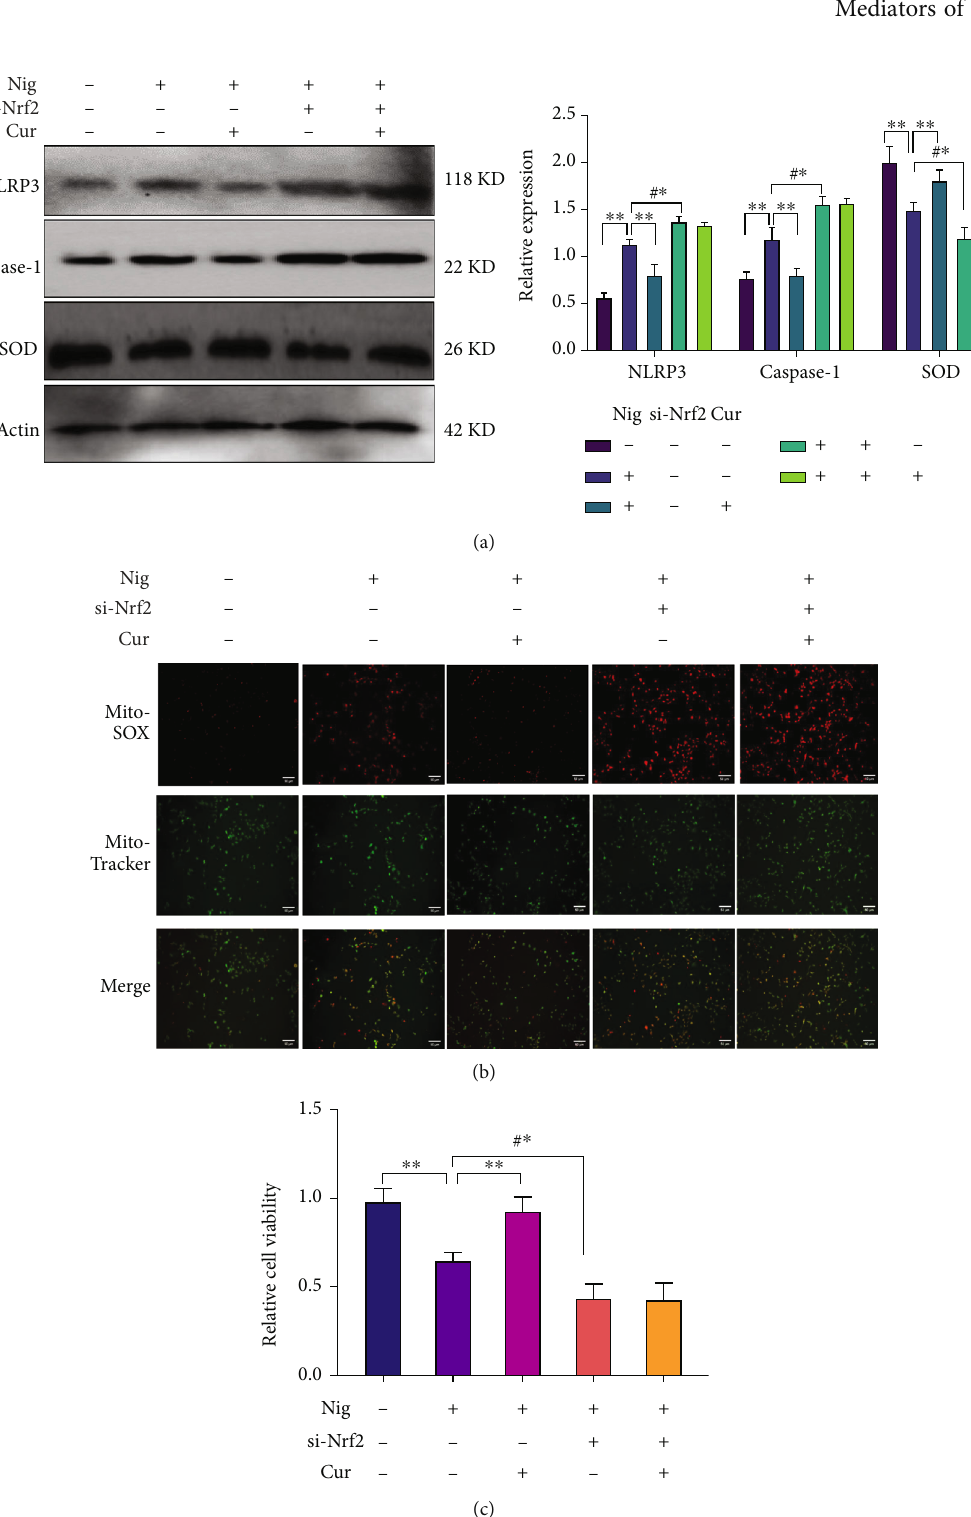
Figure 7: Curcumin ameliorated nigericin-induced pyroptosis. Nig: nigericin; the concentration used in the experiment was 10 μ M. Cur: curcumin; the dose of curcumin used in cell experiments is 14 μ M. Si-Nrf2: interference virus vector targeting the Nrf2 gene. (a) Western blotting to detect the concentration of pyroptosis-related proteins. (b) MitoTracker detects the relative expression of mitochondrial reactive oxygen species (ROS). The stronger the red, the more obvious the accumulation of ROS in the mitochondria; the mitochondrial tracer is shown in green (20x). (c) The CCK-8 test detected cell activity in each group. ∗∗ P < 0 : 001 : nigericin-added group vs. control group and curcumin-treated group. # ∗ P < 0 : 001 : Si-Nrf2 transfected group vs. Si-Nrf2 nontransfected group (in nigericin-supplemented medium). Values are expressed as the mean ± standard